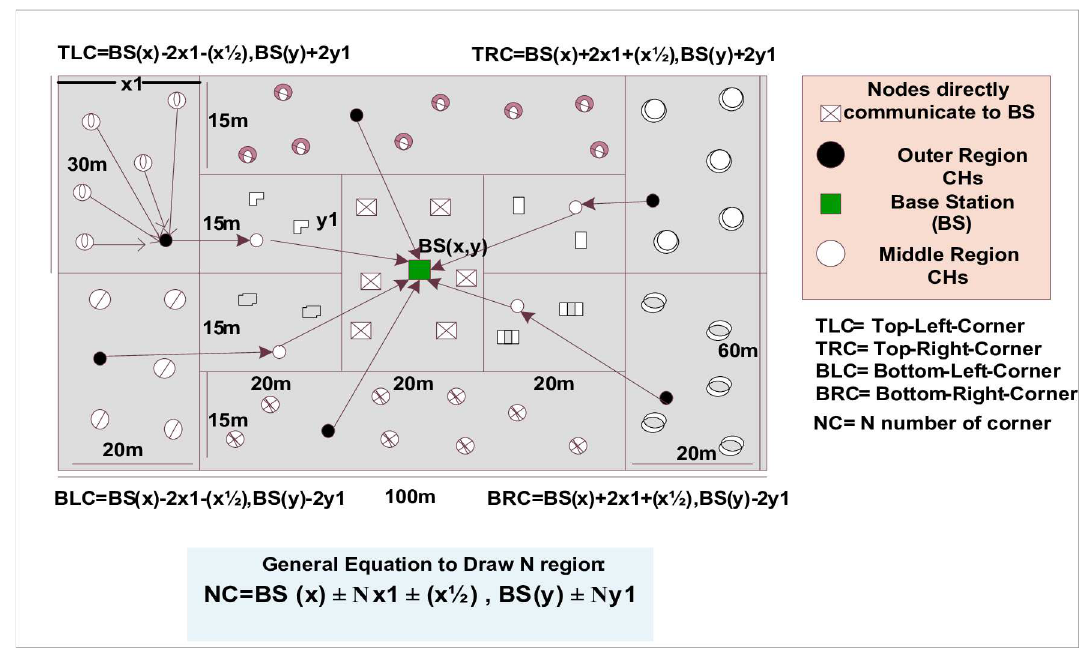
Fig 10. MH-DISCPLN modelin homogeneous and heterogeneousenvironments.